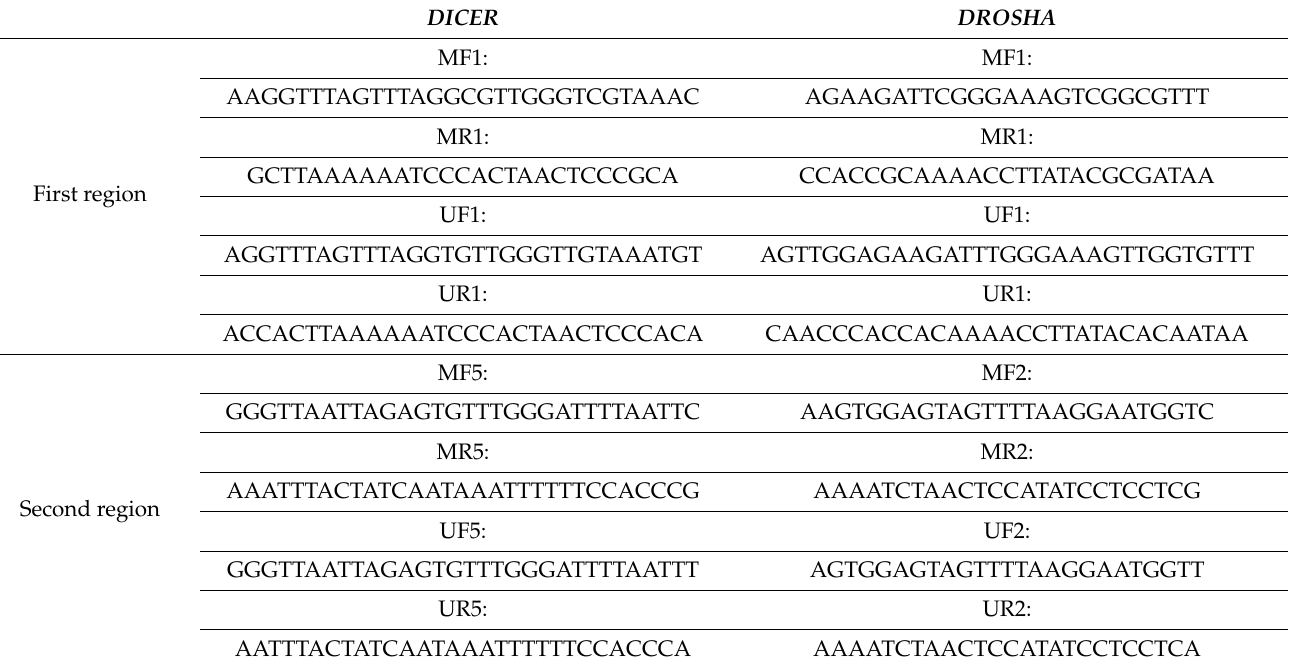
Table 2. Sequence of primers used in